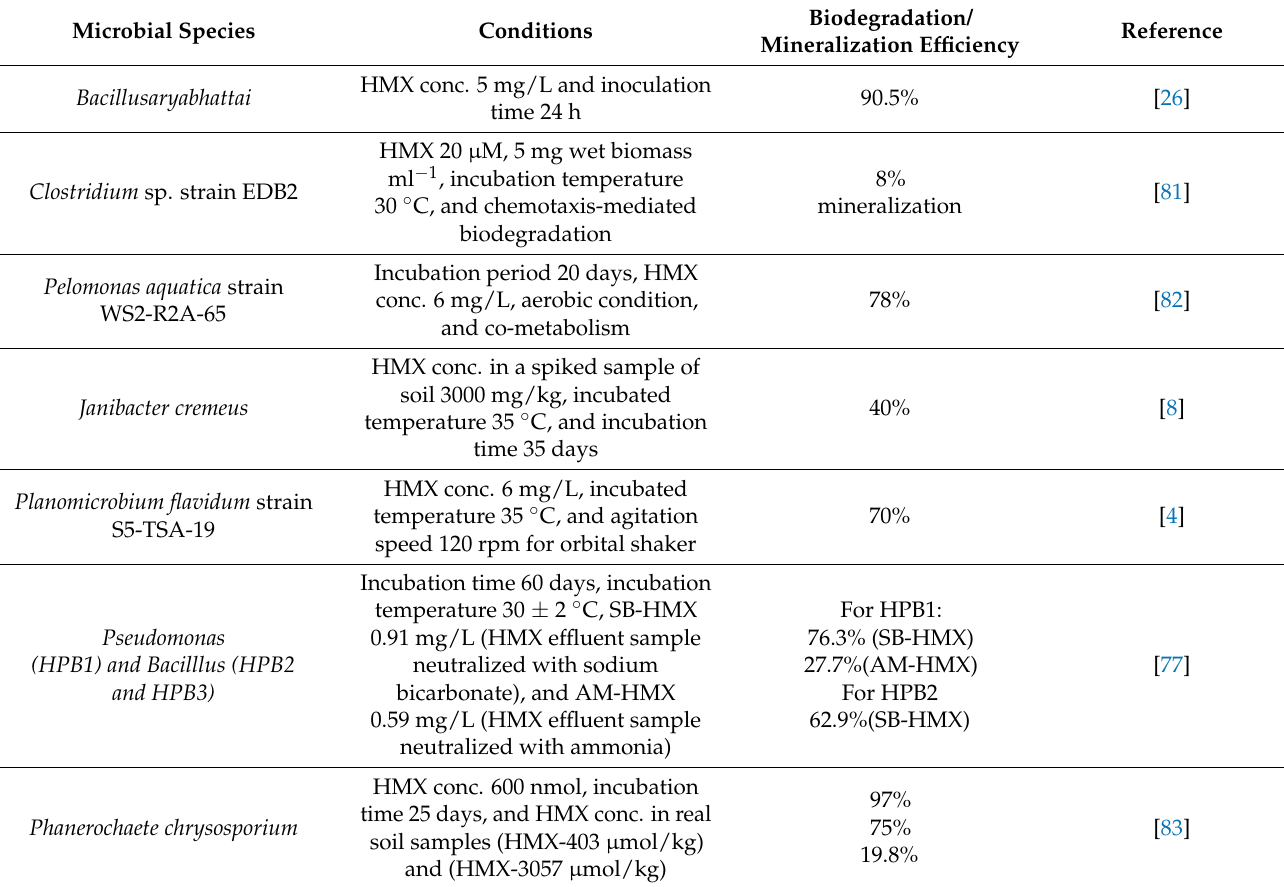
Table 3. Bioremediation approaches for HMX